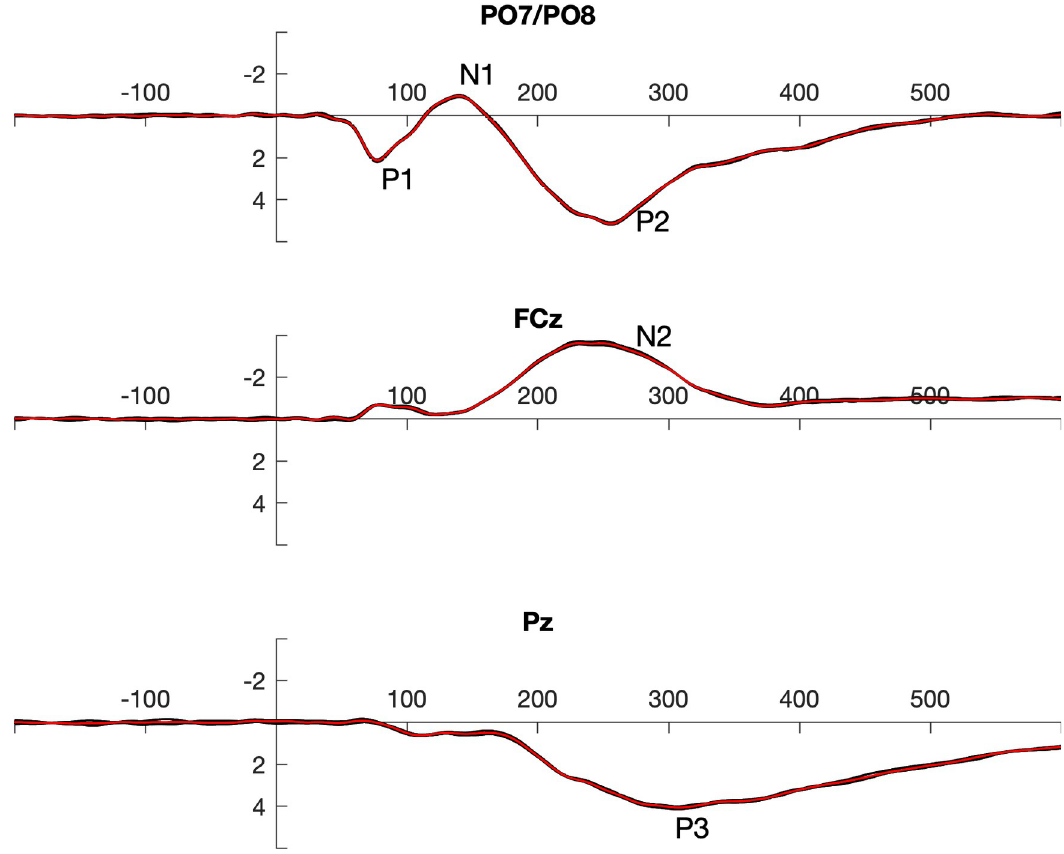
Fig 2. Grand averages in the 1/5 data split (5 black lines) superposed by the grand-grand average across all subsets (red). The data demonstrate that there was almost no variance across splits.